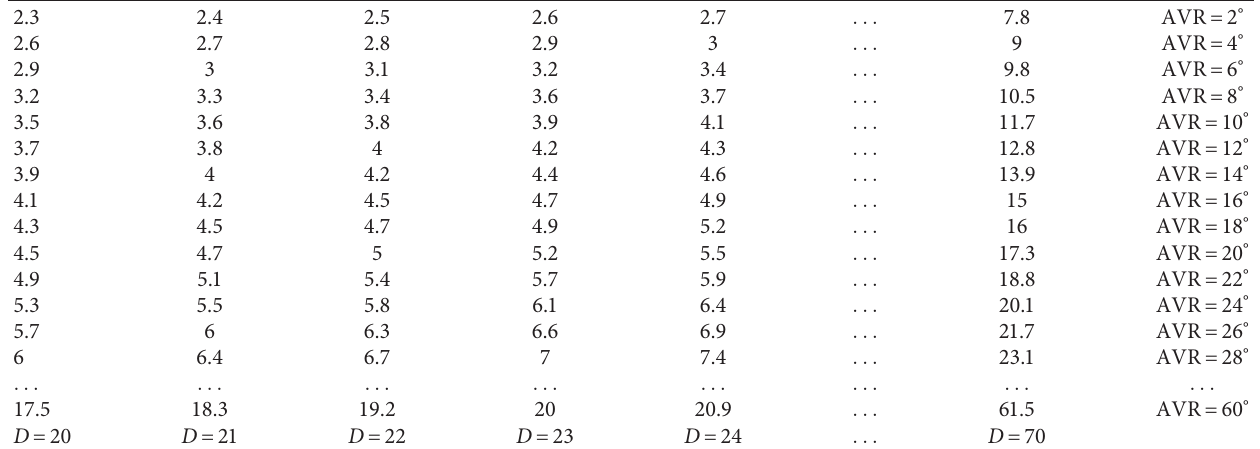
Table 1: Simplified Raimondi’s tables with data to obtain AVR. Modification of Raimondi. The quantification of the vertebral rotation in the scoliosis. Comparing experiences